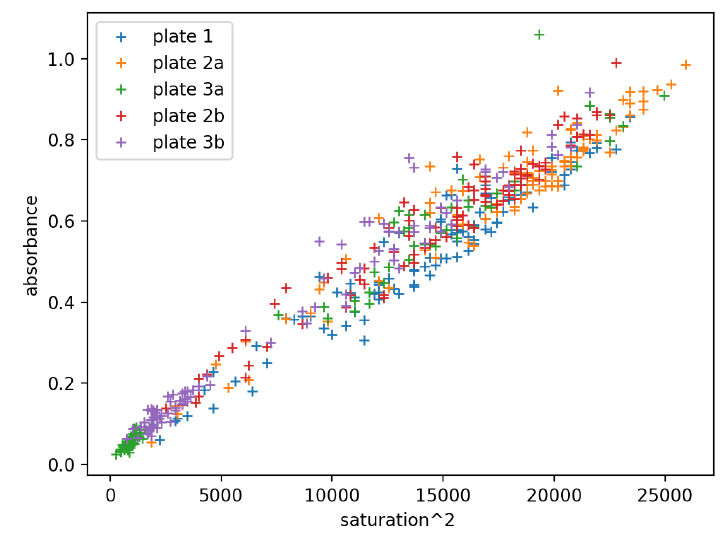
Figure 5. Absorbance vs. squared saturation, yellow samples.